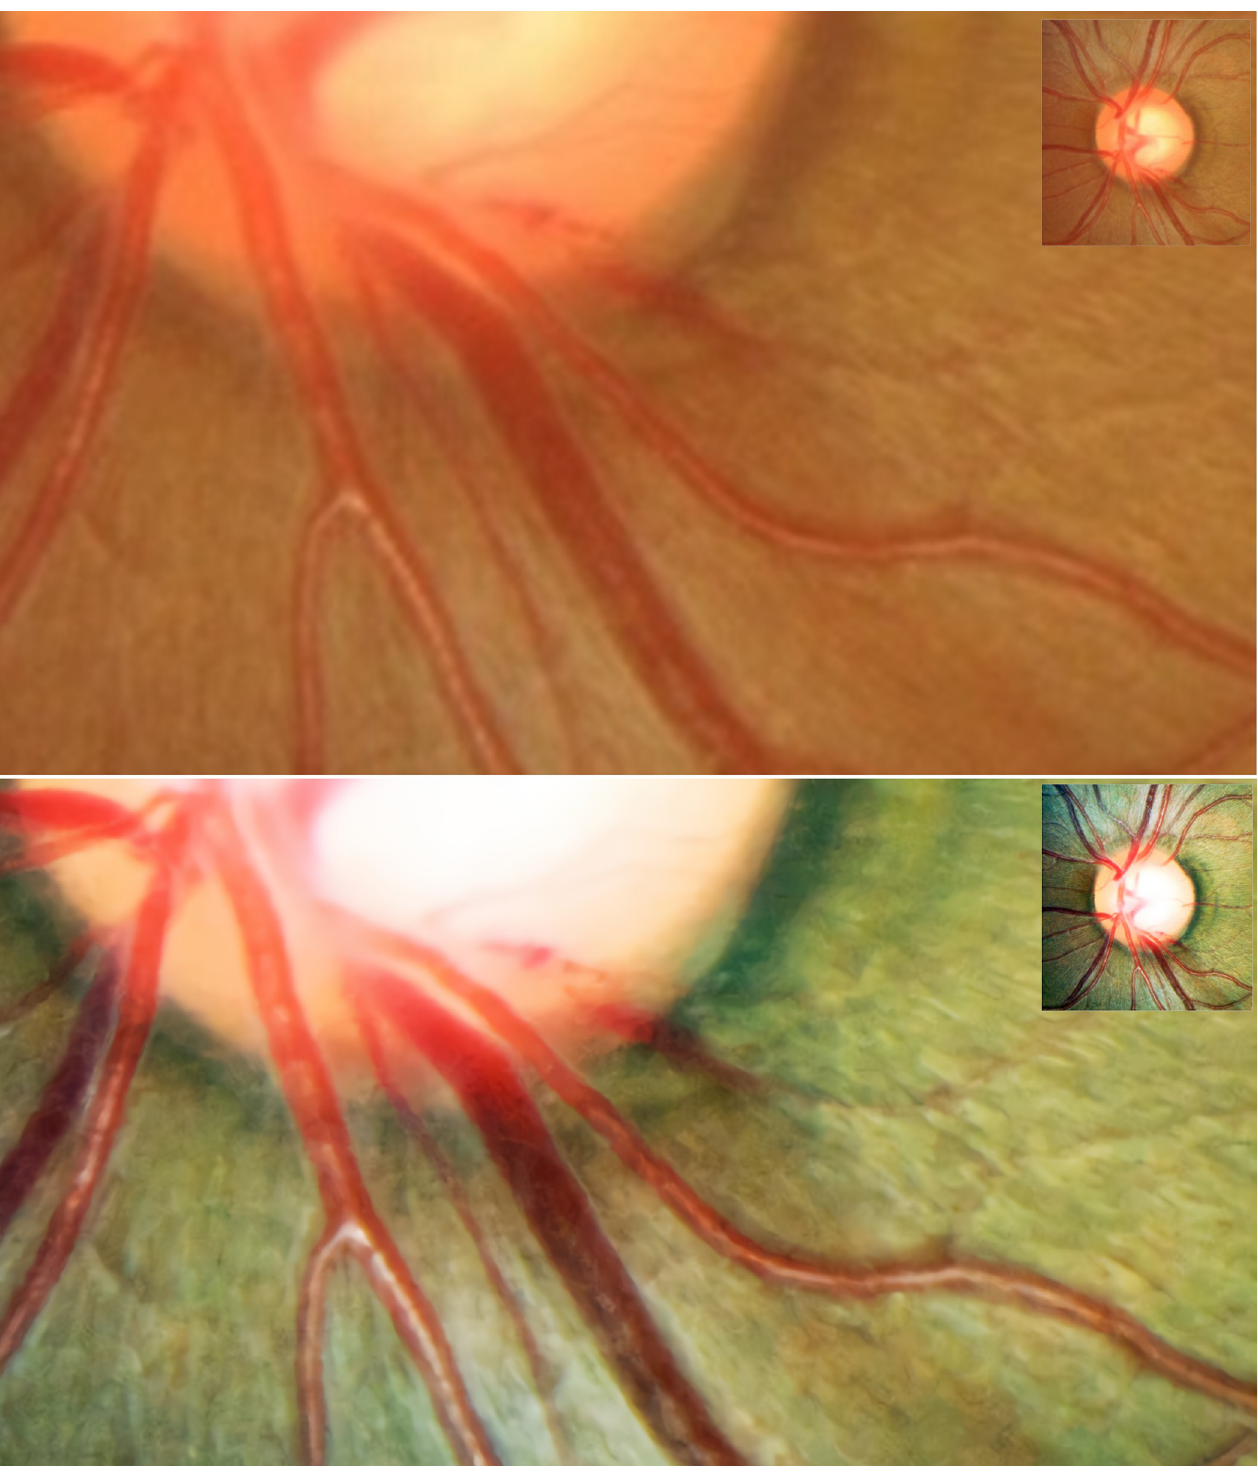
Fig 4. Representative optic-disc photography (ODP) of eye with optic disc hemorrhage (DH). (A) Magnified image of inferotemporal area in original high- resolution ODP, (B) Magnified image of inferotemporal area in deep-learning-based enhanced ODP. The enhanced ODP improved the color and spatial contrast between the DH and the background retinal